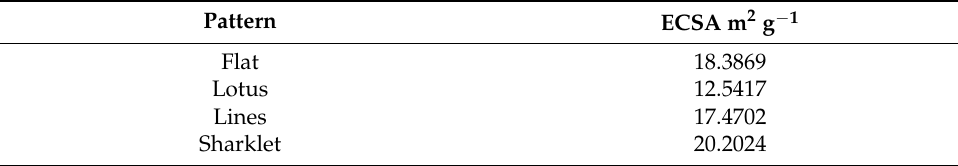
Table 4. ECSA measured from H + adsorption peak in